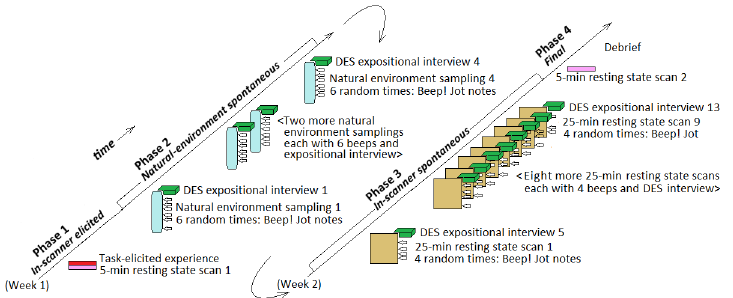
Fig 1. Schematic of the experimental